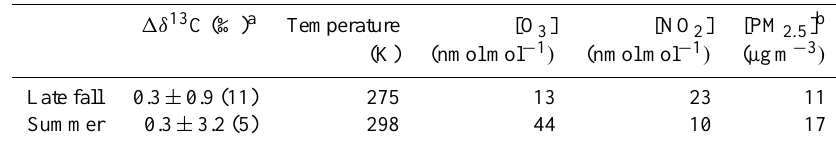
Table 4. Overview of the difference in delta values for sample pairs ( (cid:49)δ 13 C) and environmental conditions for the summer and late fall measurements shown in Fig. 4.